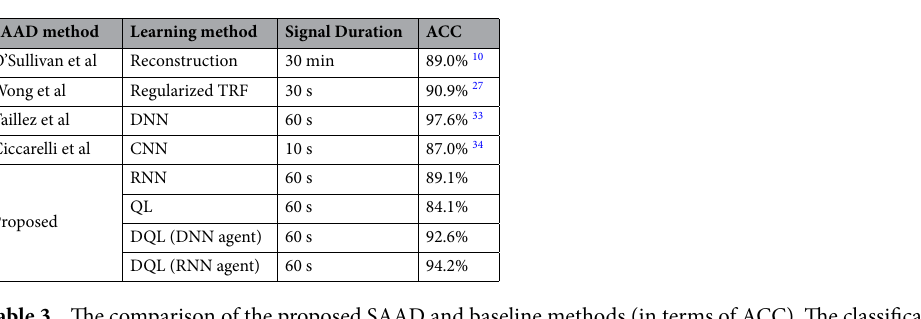
Table 3. The comparison of the proposed SAAD and baseline methods (in terms of ACC). The classification accuracies of the baselines are reported from the corresponding